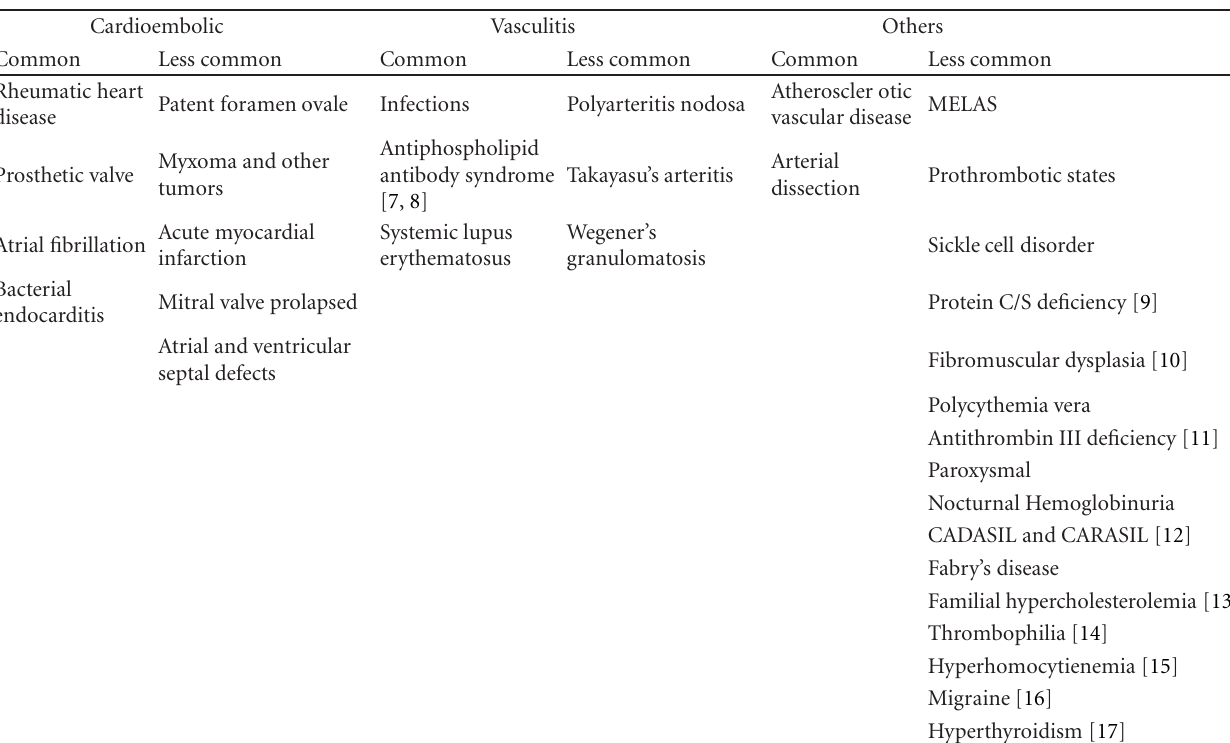
Table 1: Causes of stroke in young-Ischemic.